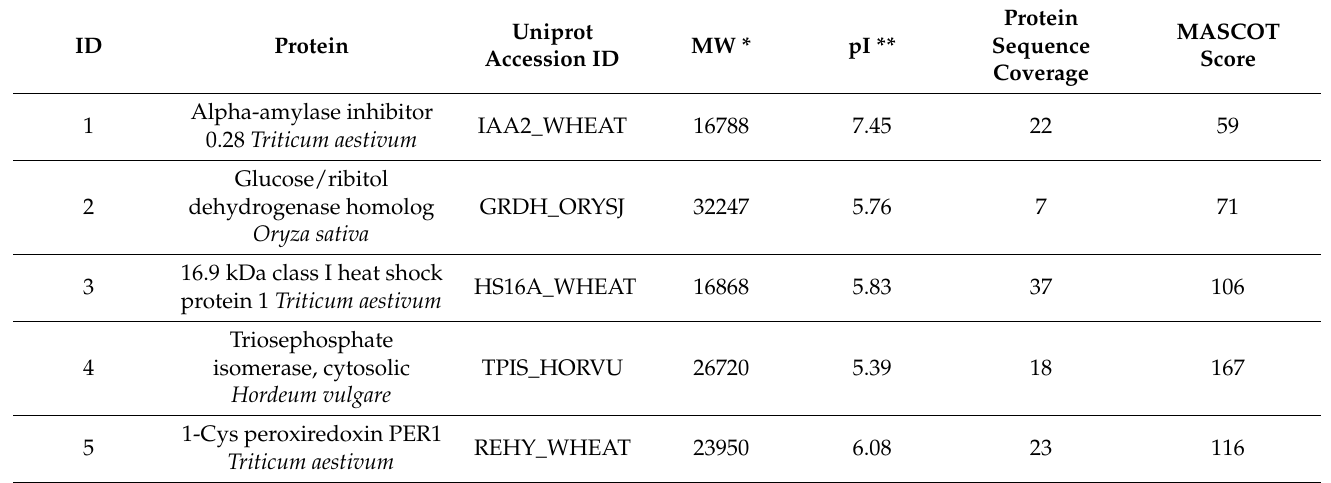
Table A1. List of identified proteins by nanoHPLC Chip tandem mass spectrometry